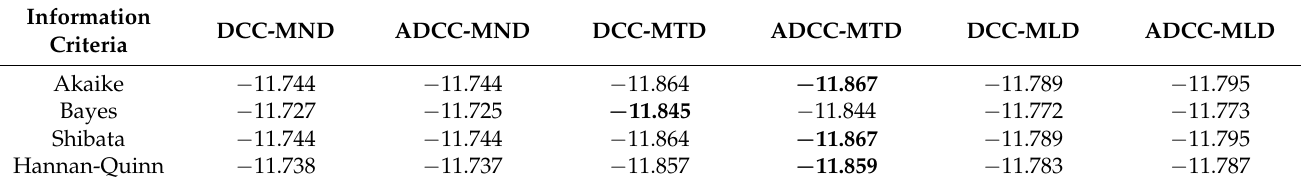
Table 3. Information criteria of (A)DCC-GARCH models for SHCI and NASDAQ pair.